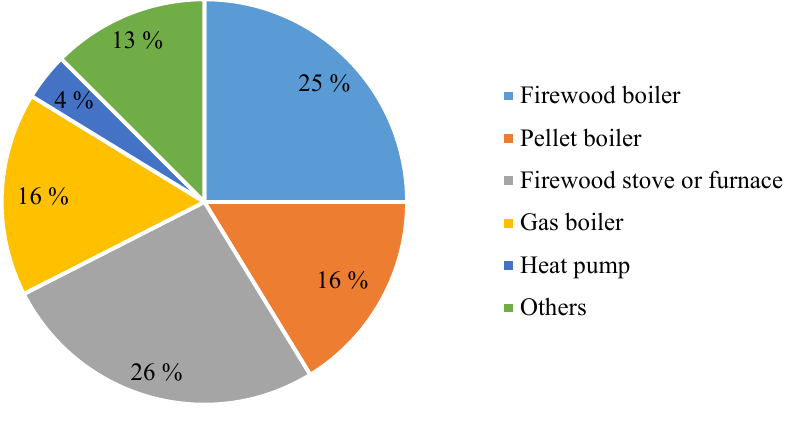
Fig. 3. Heat sources used in households by